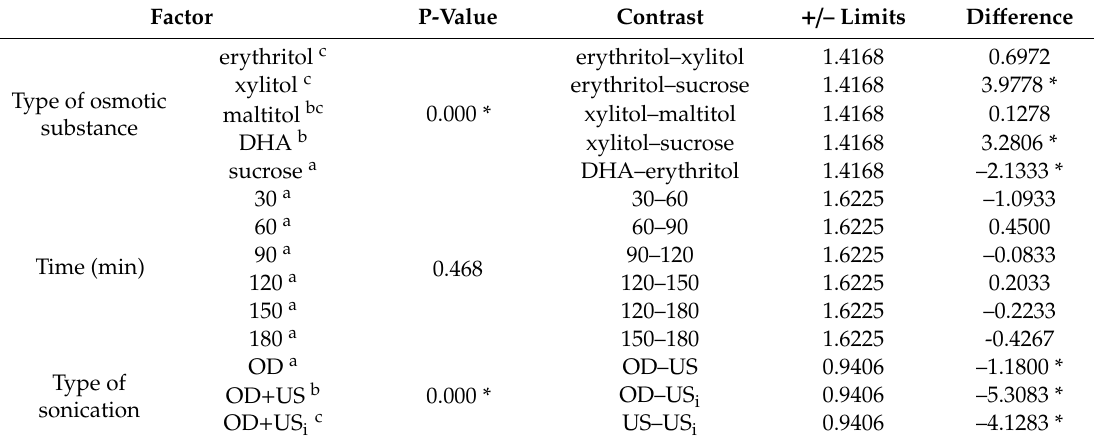
Table 15. The influence of osmotic agents and pre-treatment time on absolute colour di ff erence during